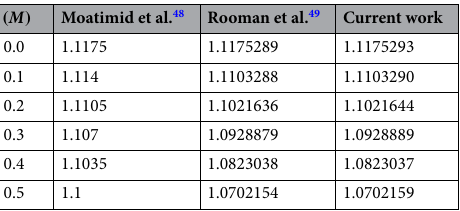
Table 5. Variation of magnetic parameter via Nusselt number 48,49 .